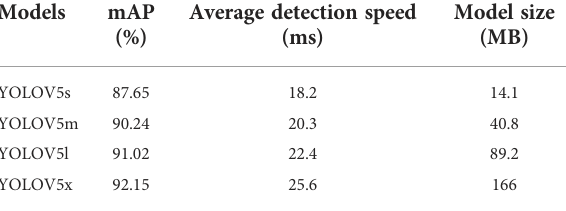
TABLE 1 Comparison of model prediction